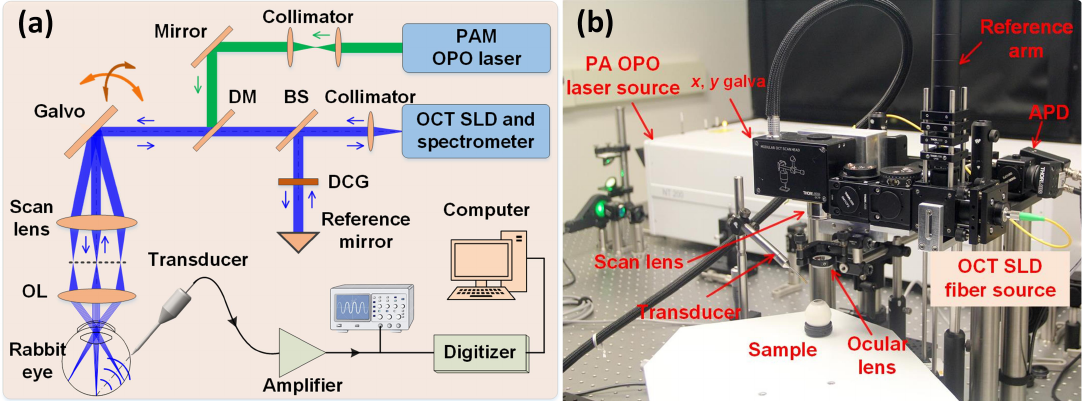
Figure 4. An optical scanning photoacoustic microscopy system for the imaging of retinal and choroidal blood vessels: ( a ) schematic diagram of optical scanning showing the ultrasound transducer position and the illumination light enters the eye and focuses on the retina, and ( b ) physical setup [14]. Adapted with permission from ref. [43]